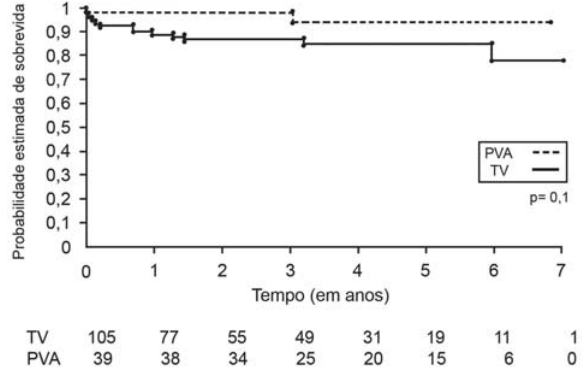
Fig. 1 - Curvas de sobrevida dos pacientes submetidos à reconstrução da raiz da aorta com o tubo valvulado (TV) e com a preservação da valva aórtica (PVA), durante o período de sete anos de seguimento